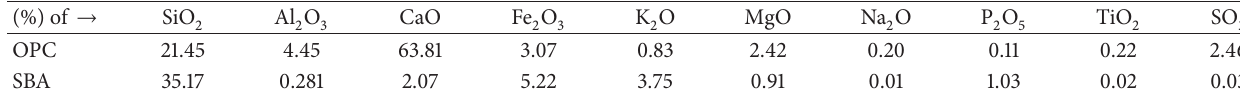
Table 2: Chemical composition of OPC [46] and SBA.